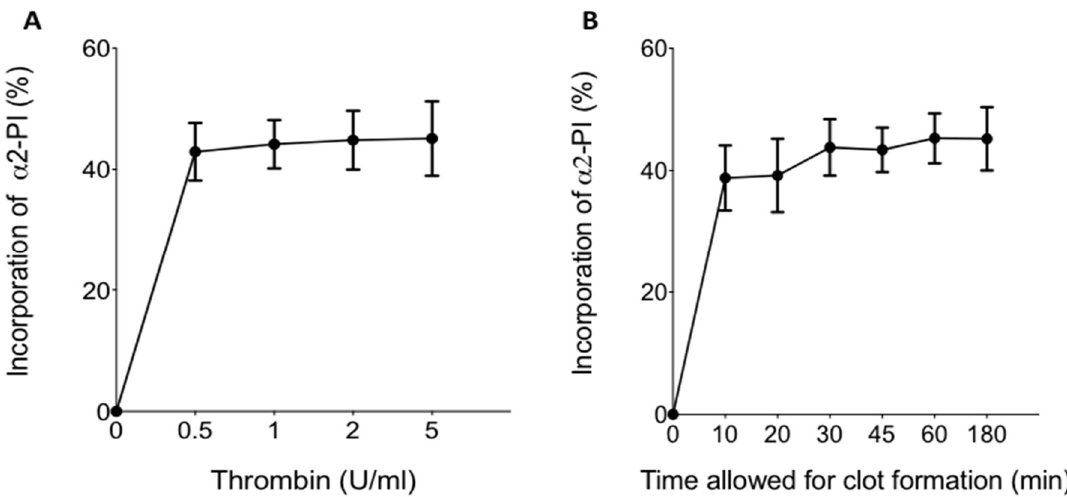
Figure 1. ( A ) Effect of thrombin concentration on the incorporation of α 2-plasmin inhibitor ( α 2-PI) into fibrin clots.; ( B ) time dependence of α 2-PI incorporation into fibrin clot. Dots and whiskers indicate mean and standard deviation of the results of 10 parallel experiments.